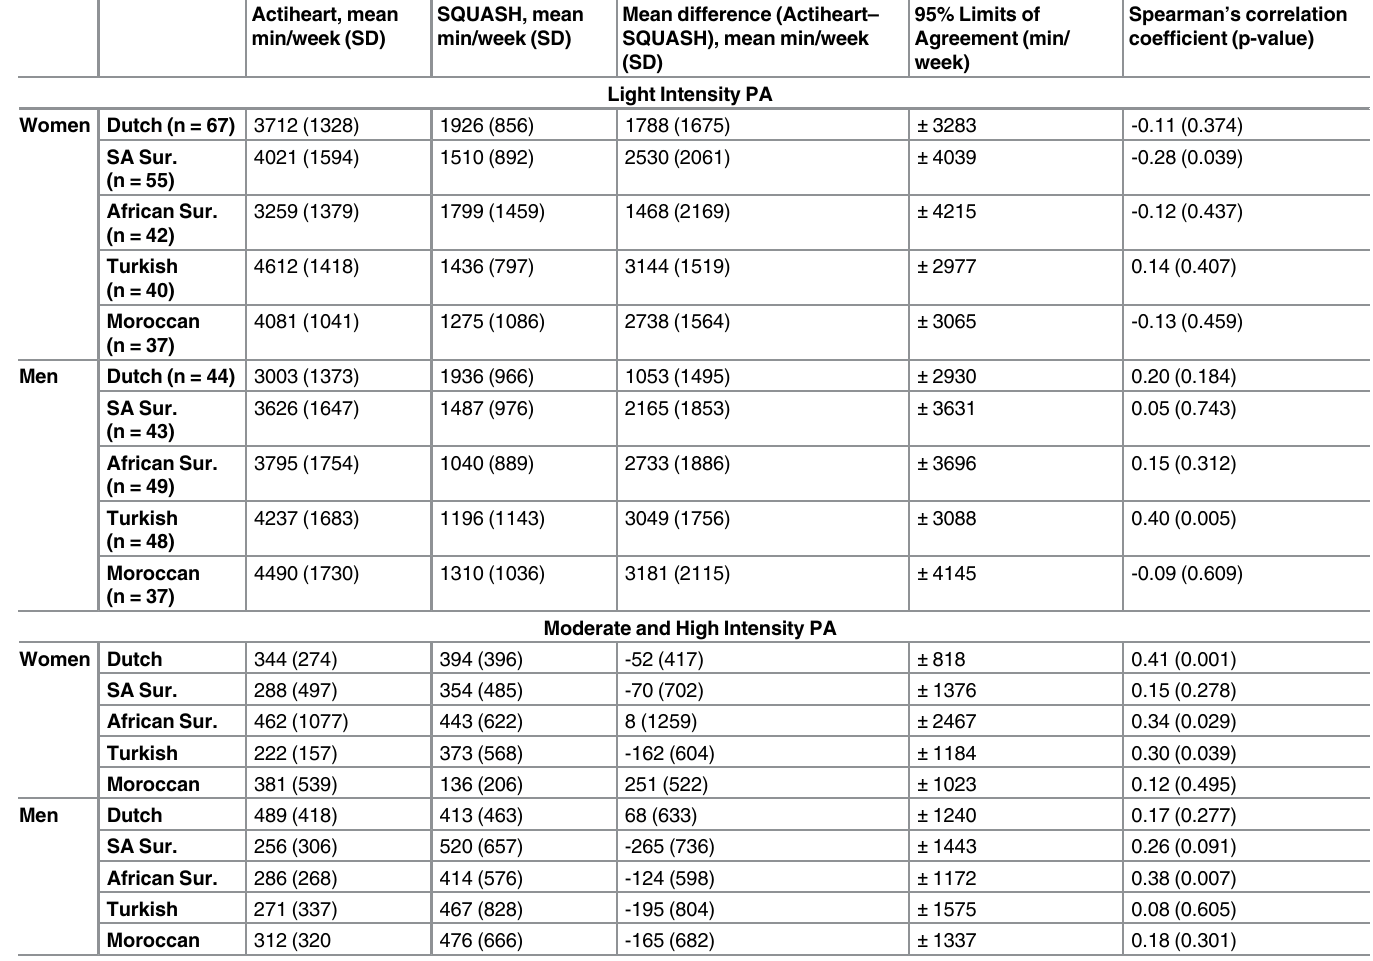
Table 3. Construct validity – differences between objective (Actiheart) and subjective (SQUASH) levels of Physical